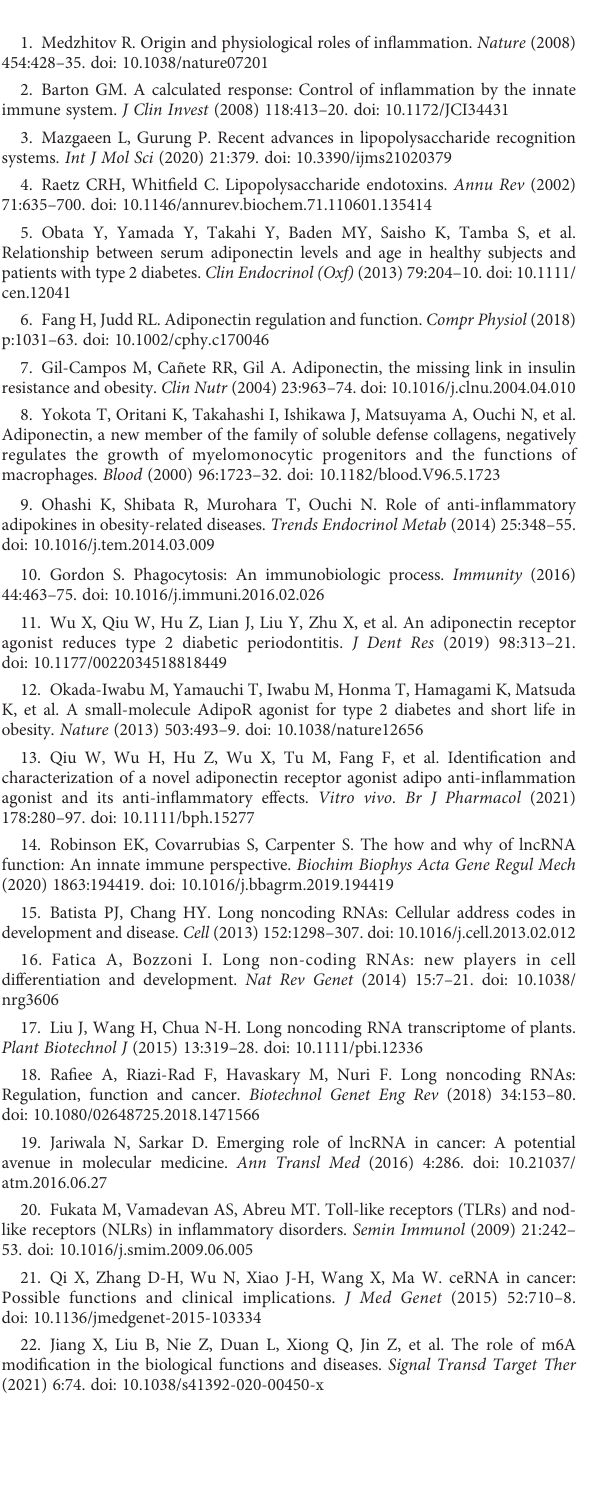
SUPPLEMENTARY FIGURE 5 Coexpression between 33 m6A-related mRNAs and 110 DElncRNAs. SUPPLEMENTARY FIGURE 6 Coexpression between 2 m6A-related mRNAs and 16 lncRNAs.